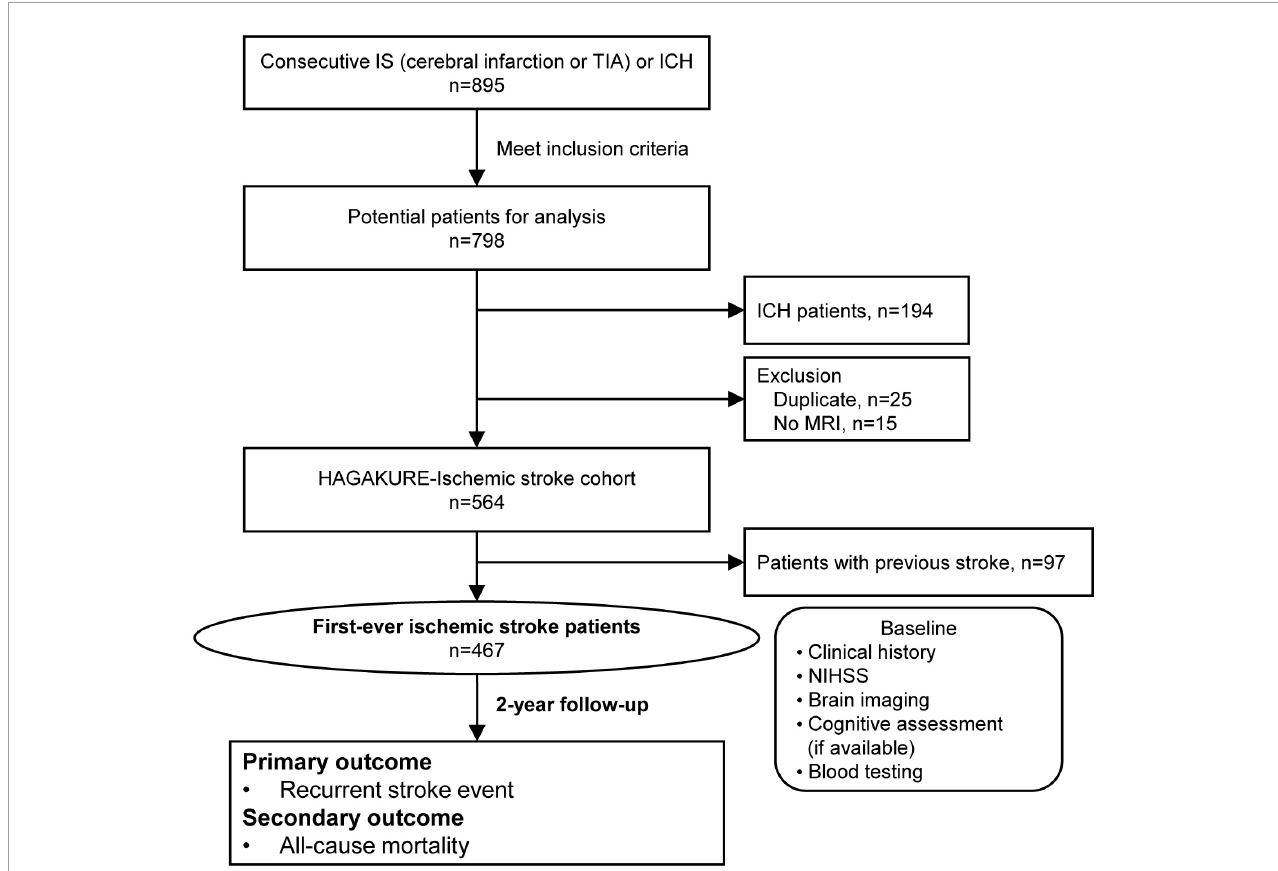
FIGURE1 Flow diagram of patient selection for the HAGAKURE study. The HAGAKURE study is a single-center, prospective, longitudinal, observational study investigating the association between cerebral small vessel disease burden in patients with stroke (cerebral infarction, TIA, or ICH) and their associations (e.g., outcomes). ICH, intracerebral hemorrhage; IS, ischemic stroke; MRI, magnetic resonance imaging; TIA, transient ischemic